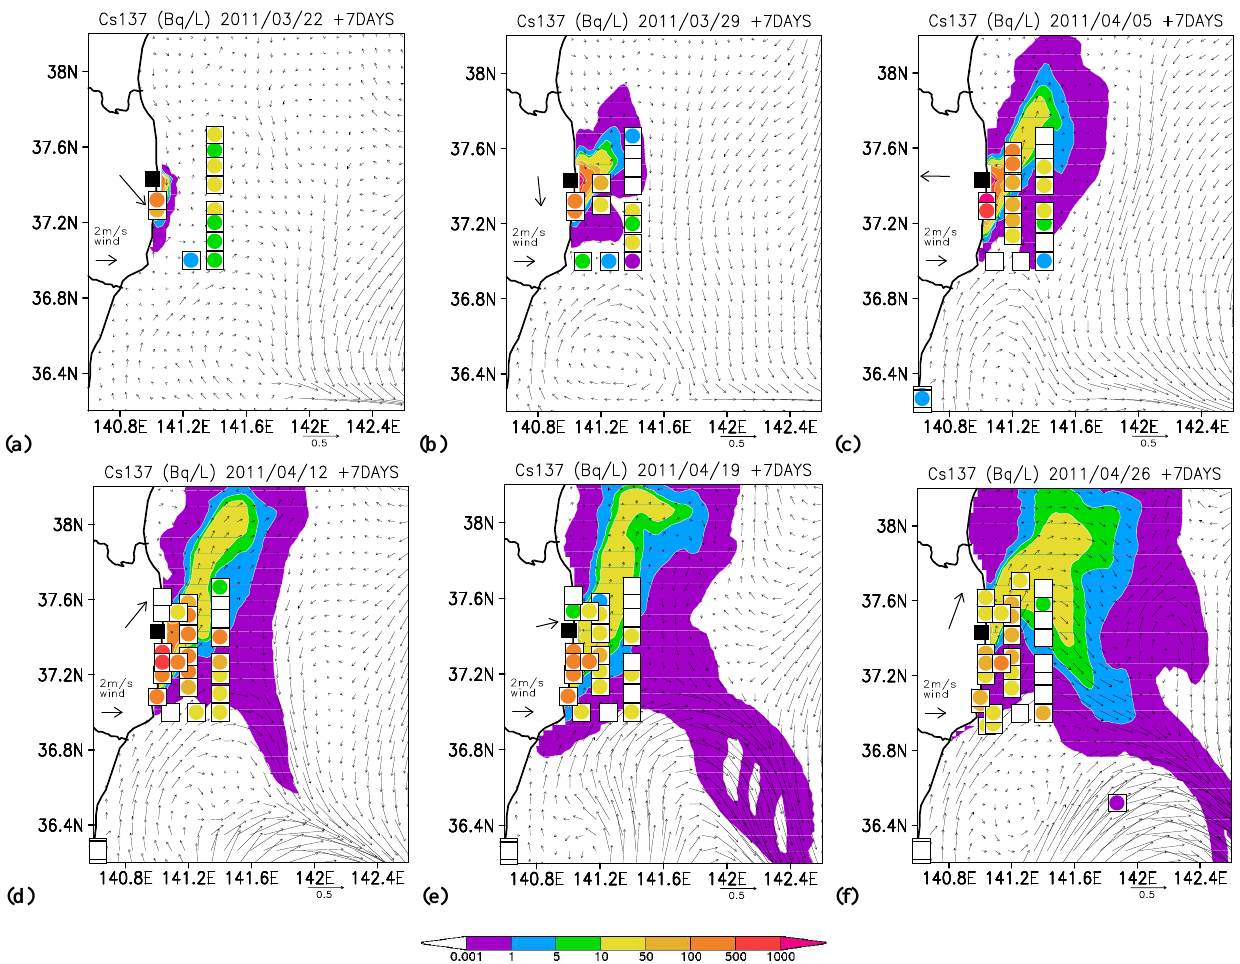
Fig. 5. Time sequences of weekly averaged concentration (in BqL) at 1m depth (shade) of 137 Cs around Fukushima simulated by the JCOPE- T-2-C first-guess simulation. Vectors indicate the weekly averaged current at 1m depth used for the simulation. The beginning days of the weekly averages are shown at top of panels. The position of FNPP is denoted by a closed square. Closed circles surrounded by open squares indicate in situ observation points during each averaged period. Colors of the closed circles denote ranges of the concentration. White color means that the concentration was not detected there. A vector shown in left of the FNPP point indicates the weekly averaged wind of JMA MSM on a grid in front of